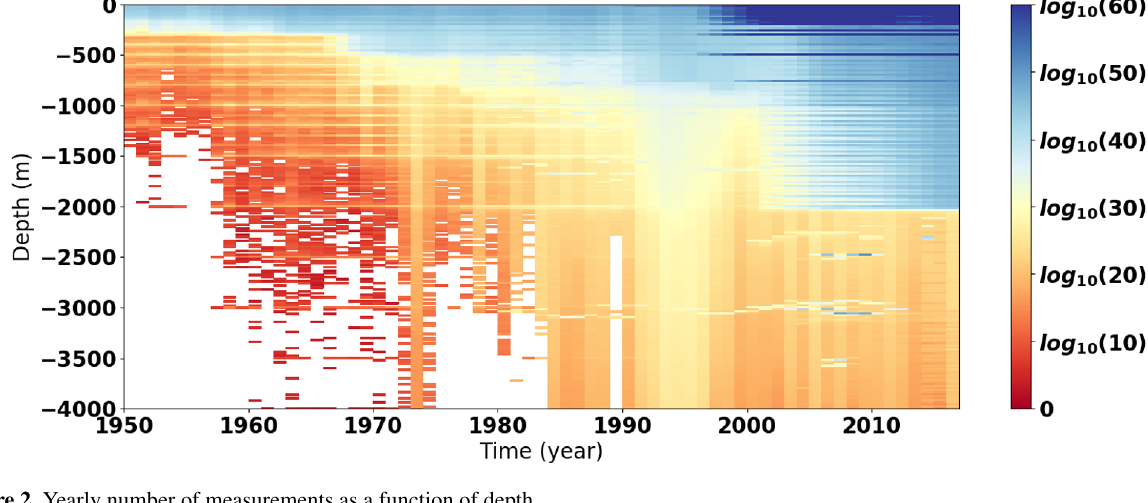
Figure 2. Yearly number of measurements as a function of depth.